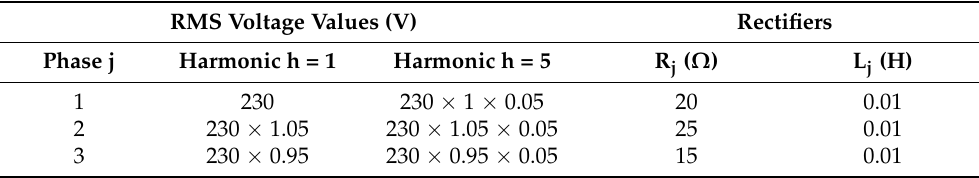
Table 4. RMS values of the supply voltage and RL branch parameters on the dc side of the rectifiers.